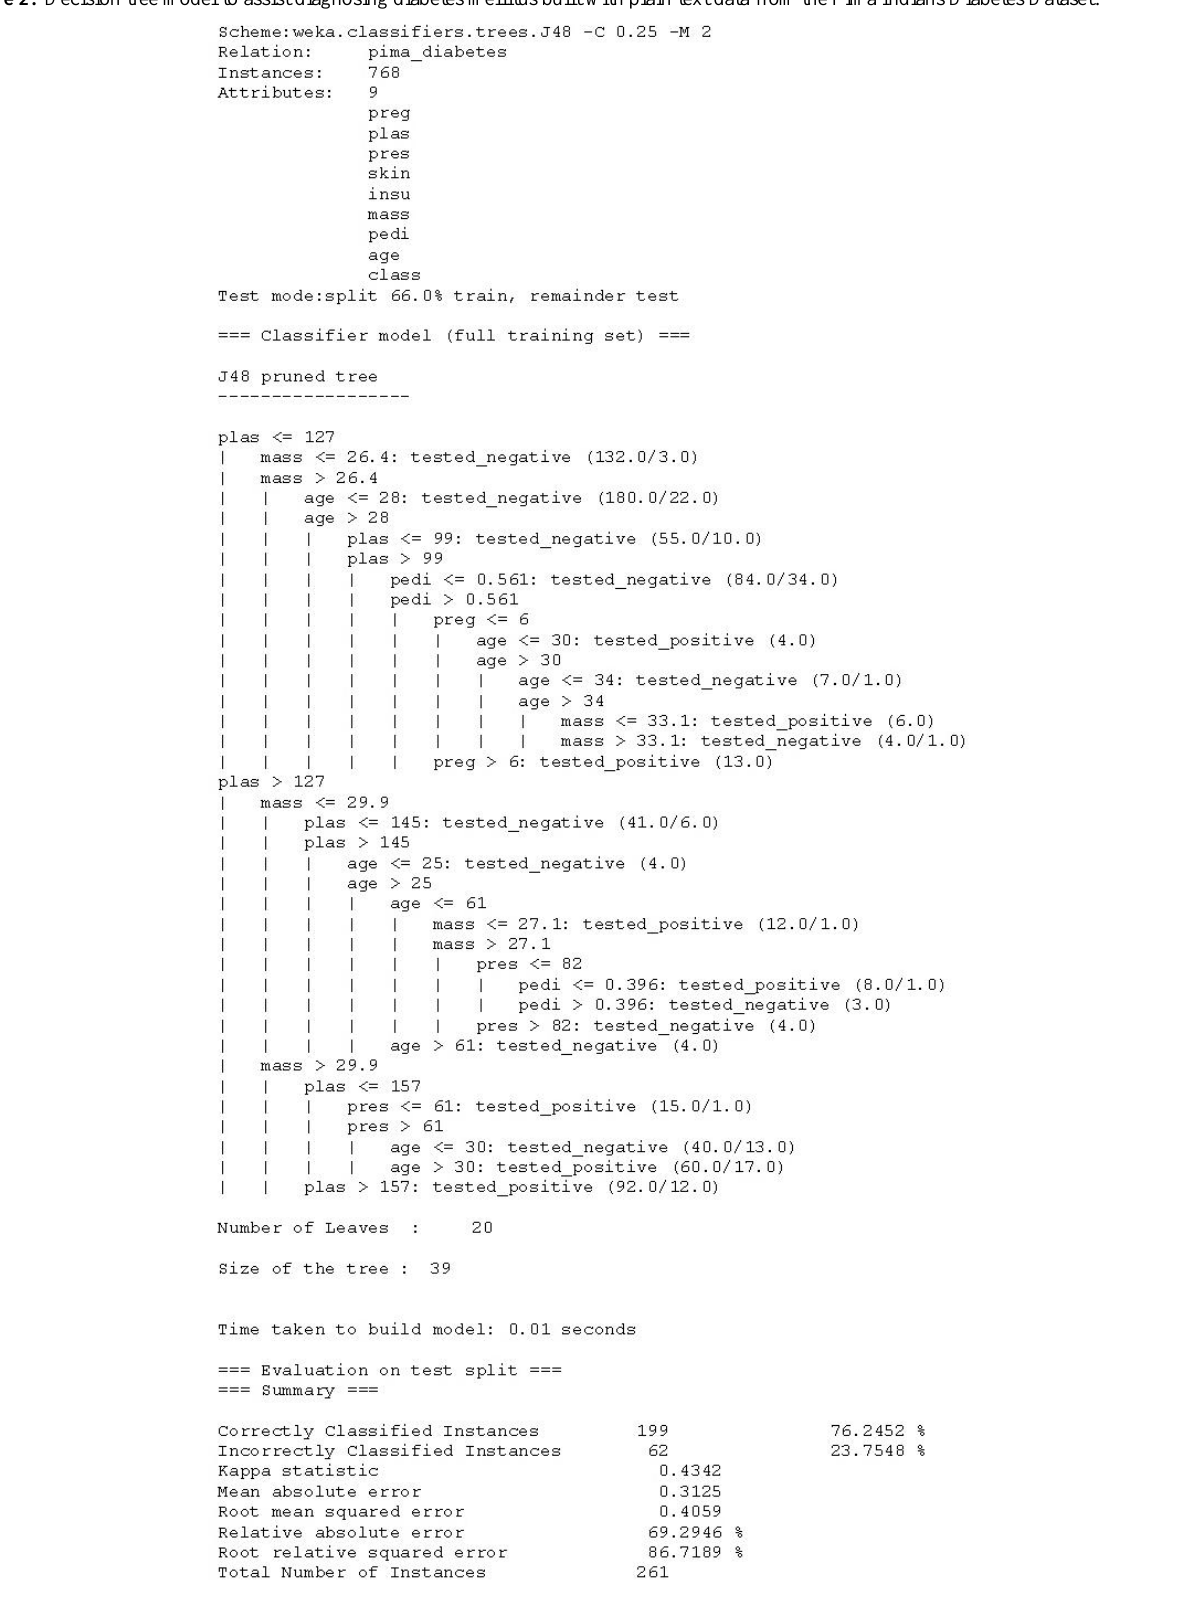
Figure 2. Decision tree model to assist diagnosing diabetes mellitus built with plain text data from the Pima Indians Diabetes